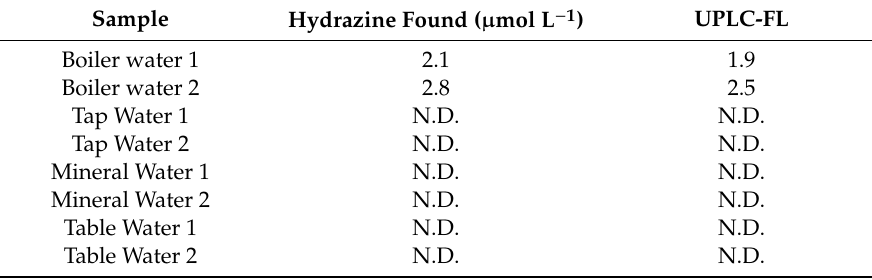
Table 2. Analysis of real samples by the zone fluidics (ZF)